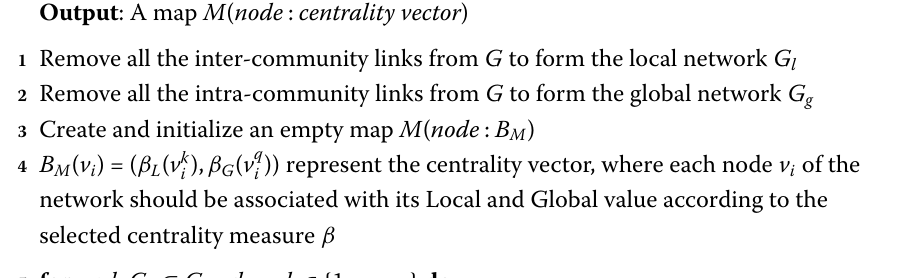
Algorithm 1: Generic computation of the Modular